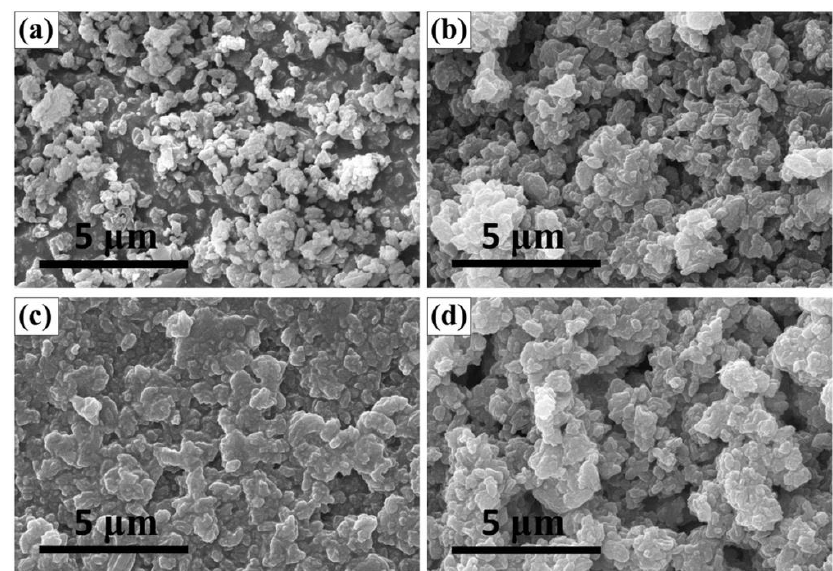
Figure 3. SEM images of zeolite ZSM-5 and its immobilized catalysts: ( a ) ZSM-5; ( b ) ZSM-5-HO-[PECH-MIM]Cl/[ZnBr 2 ]; ( c ) ZSM-5-HOOC-[PECH-MIM]Cl/[ZnBr 2 ]; and ( d ) ZSM-5-H 2 N-[PECH-MIM]Cl/[ZnBr 2 ].